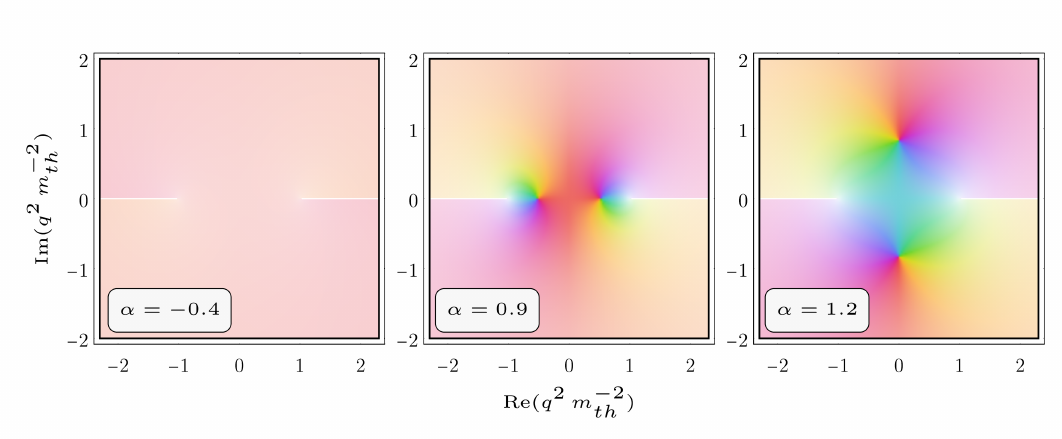
Figure 18 . Pole structure of the function P ( z ) in eq. (6.1) in the complex q 2 -plane for three different values of α , corresponding to the cases of complex-conjugate poles ( α > 1 ), two real poles ( 0 < α < 1 ) and no additional poles ( α < 0 ). These are the only cases realized within the propagator of eq. (6.1), as also shown in figure